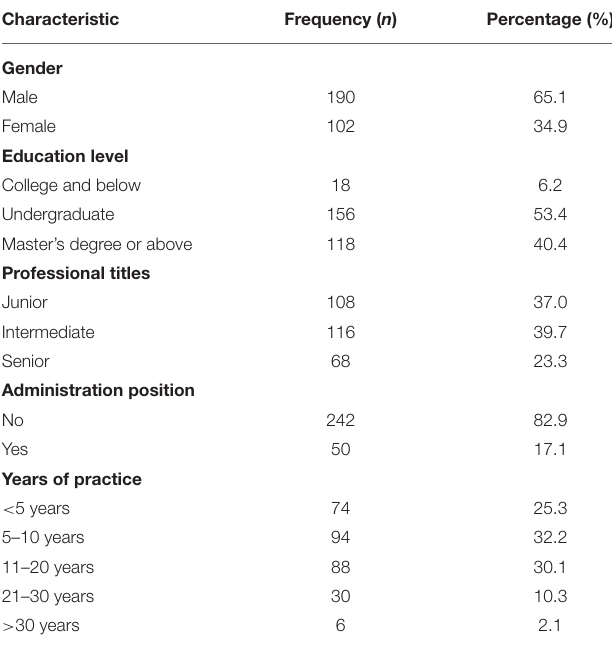
TABLE 1 | Socio-demographic characteristics of the 292